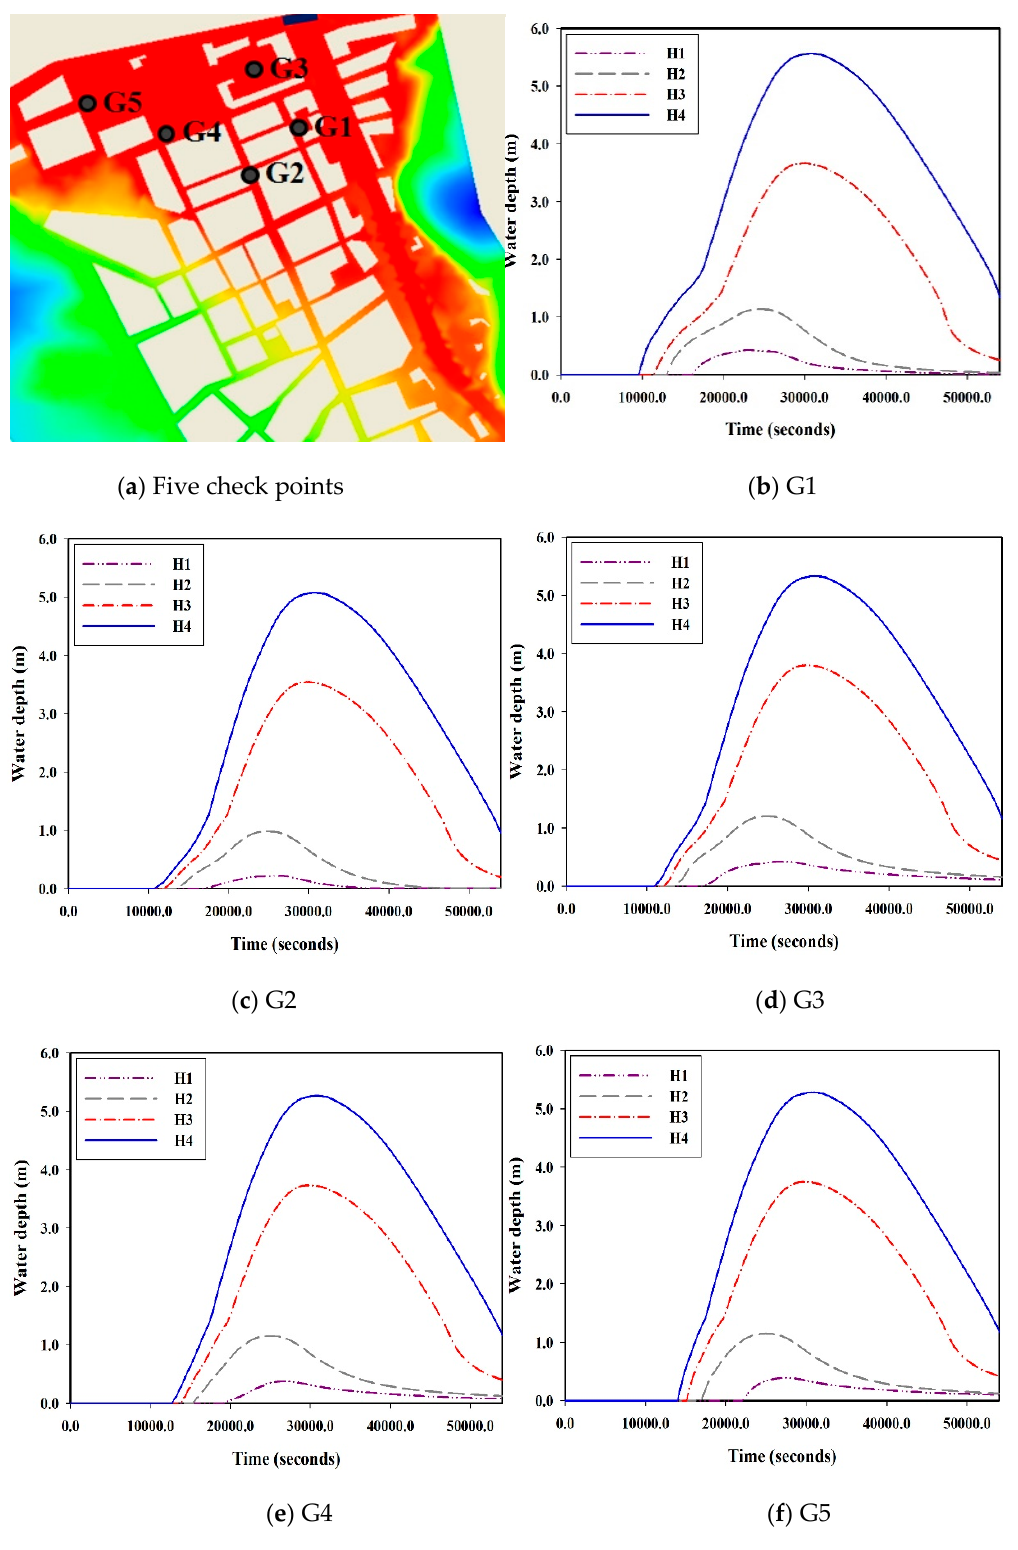
Figure 14. Temporal variation in the inundated water depth at the five check points in the four scenarios of the flood inflow rate.